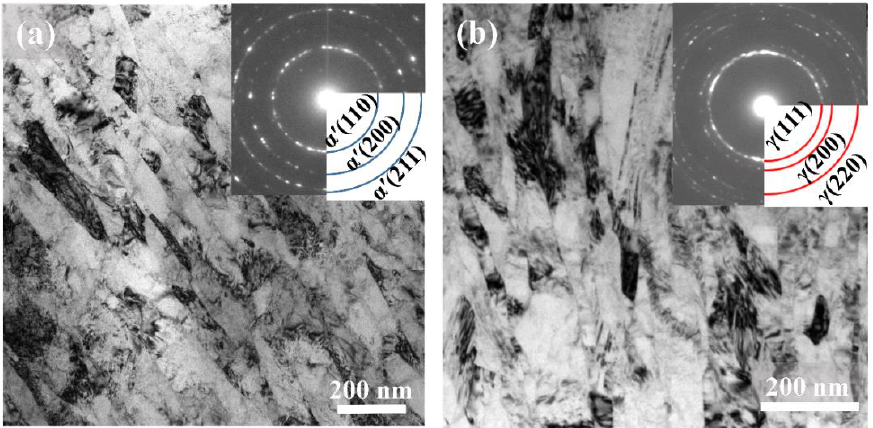
Figure 2. Typical bright-field TEM images at a depth of ~10 μm from the treated surface in ( a ) the SMRT-25 and ( b ) the SMRT-280 samples. Inserts show the corresponding SAED patterns.